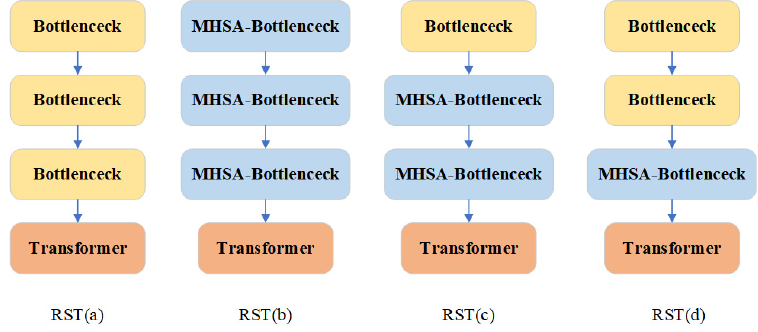
Figure 11. The arrangement of four TRS model architectures. Table 12. Comparison of classification accuracy between four different architectures. Architecture